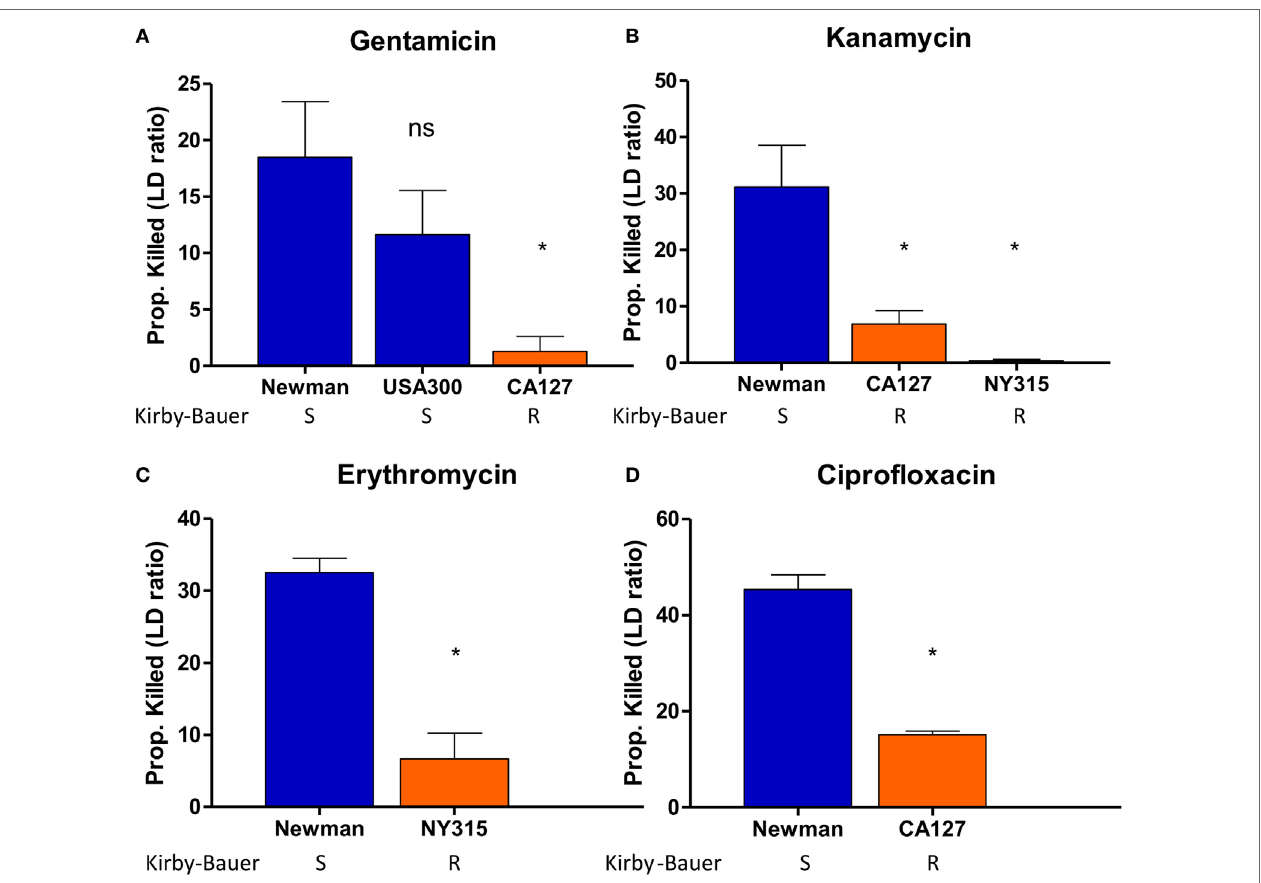
FigUre 3 | SYBR Green I/propidium iodide (PI) stain can distinguish between R (resistant) and S (sensitive) strains of Staphylococcus aureus against various antibiotics in 30 min. Treatment with (a) gentamicin (100 µg/ml), (B) kanamycin (100 µg/ml), (c) erythromycin (400 µg/ml), and (D) ciprofloxacin (100 µg/ml) was added to various overnight S. aureus strains diluted to 1:25 (OD600 = 0.1). After incubation with antibiotics for 30 min, SYBR Green I/PI staining was performed and distinguished the strains and their respective susceptibility categories. All susceptibility results were in concordance with results from the Kirby–Bauer disk diffusion test (Student’s t -test, * p < 0.05). Data represent the means +